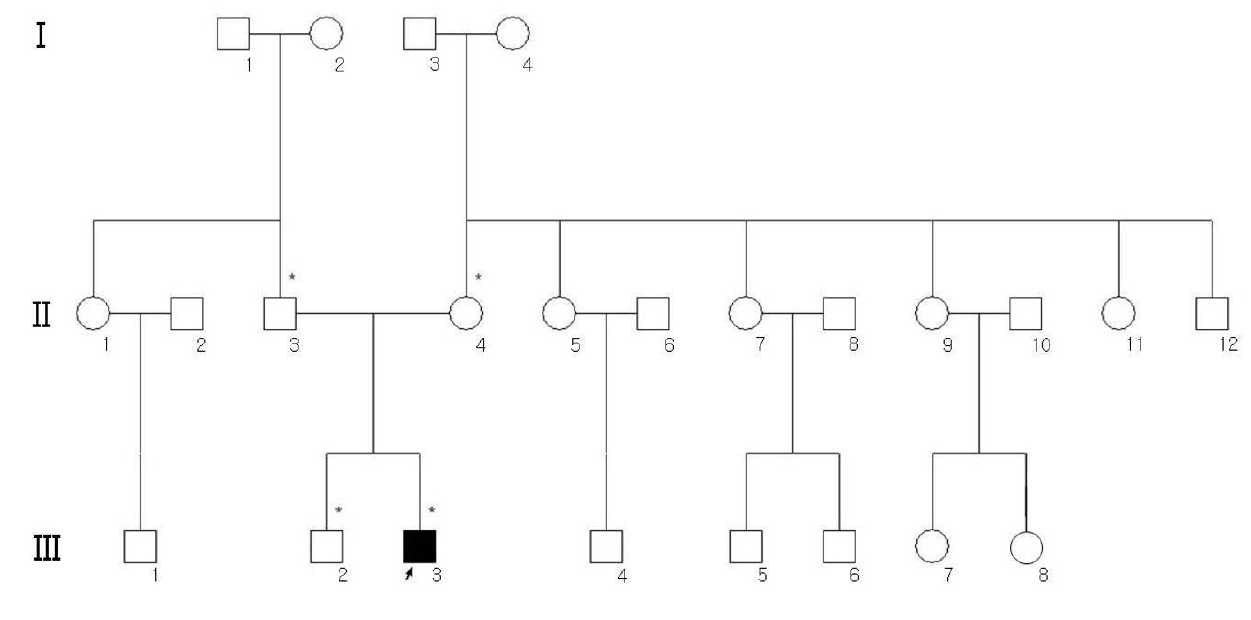
who was available for genetic